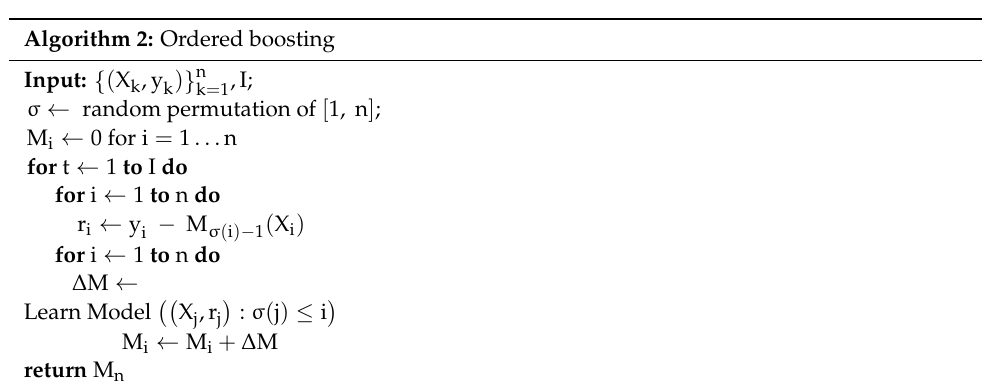
Algorithm 2: Ordered boosting